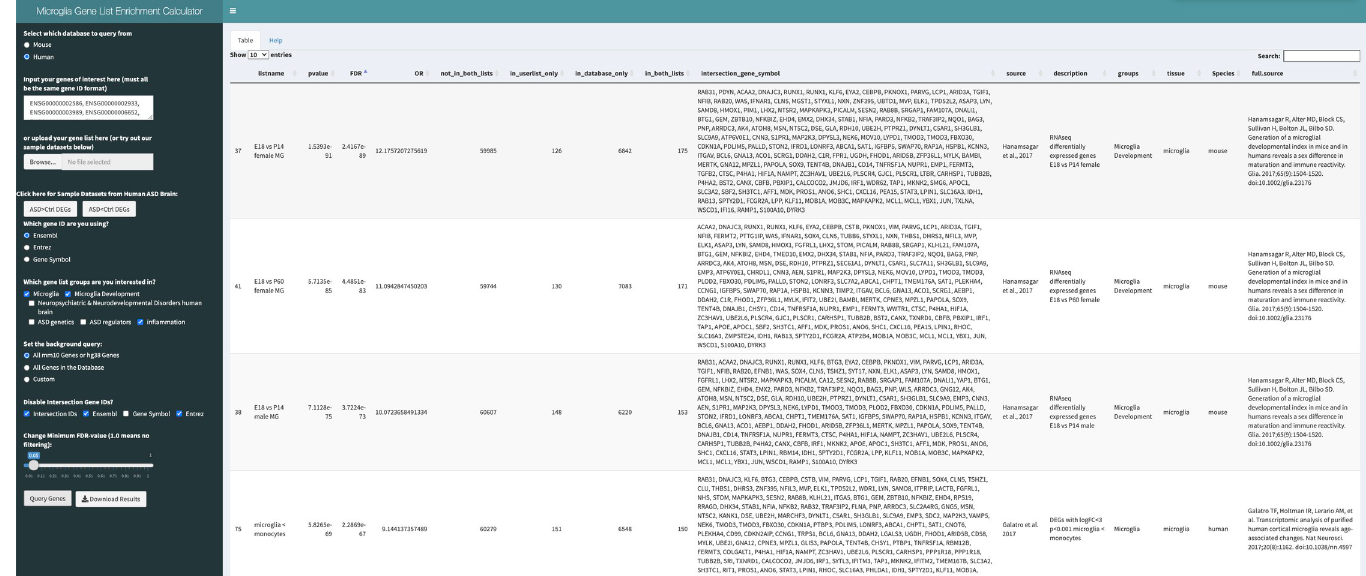
Fig 2. Preview of MGEnrichment, as previewed on a Web Browser. The left panel includes user-input and possible modifications to results, while the table on the right outputs the user query results for each gene list.